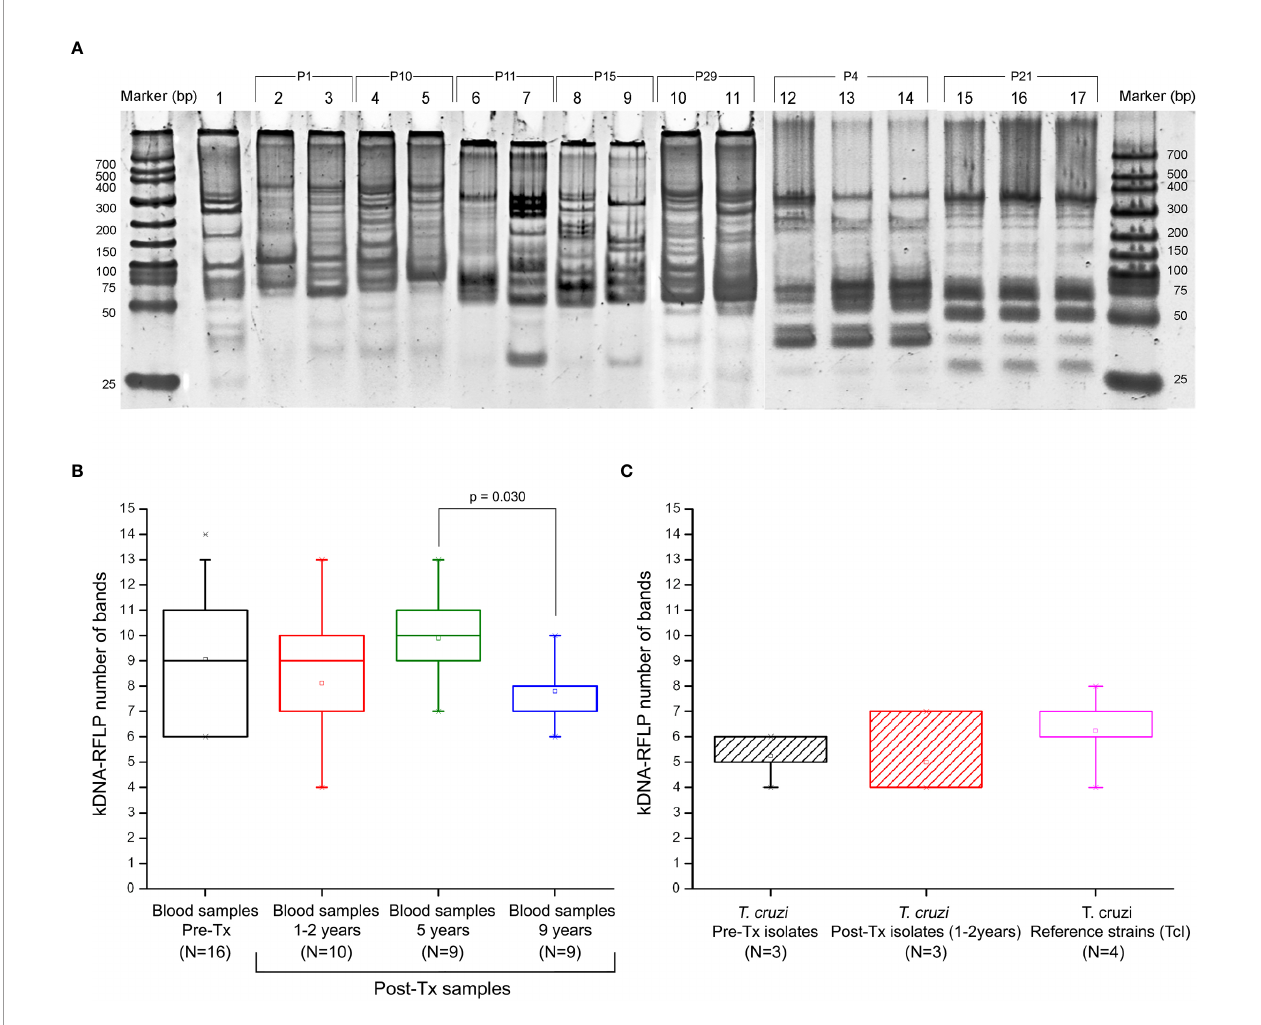
FIGURE 4 | Pro fi le of minicircle signatures in parasite populations by kDNA-PCR restriction fragment polymorphism (RFLP). (A) Example of comparative band analysis of minicircle pro fi les obtained by RFLP-PCR between patients ’ parasite populations; (B) Boxplot distribution of number bands obtained by RFLP-PCR throughout the follow-up in the blood samples. (C) Distribution of the boxplot of number of digestion fragments obtained by RFLP-PCR in Trypanosoma cruzi isolates obtained from hemocultures and TcI reference strains. 1: Reference strain (DTU I - Dm28c); 2-3: Sample P1 (Pre-Tx and 5 years Post-Tx); 4-5: Sample P10 (Pre-Tx and 5 years Post-Tx); 6-7: Sample P11 (Pre-Tx and 5 years Post-Tx); 8-9: Sample P15 (Pre-Tx and 5 years Post-Tx); 10-11: Sample P29 (Pre-Tx culture isolate and 1 year Post-Tx culture isolate); 12-14: Sample P4 (Pre-Tx, 5 years and 9 years Post-Tx); 15-17: Sample P21 (Pre-Tx, 5 years and 9 years Post-Tx). The JC results shown in the box “ reference strains ” were obtained from the comparison of the Ms from the Dm28c, SilvioX10, gal4, and CMA strains. P value indicates signi fi cant differences between populations (Mann-Whitney U test; p<0.05). Data in the boxplot are presented as median and interquartile range of 25 to